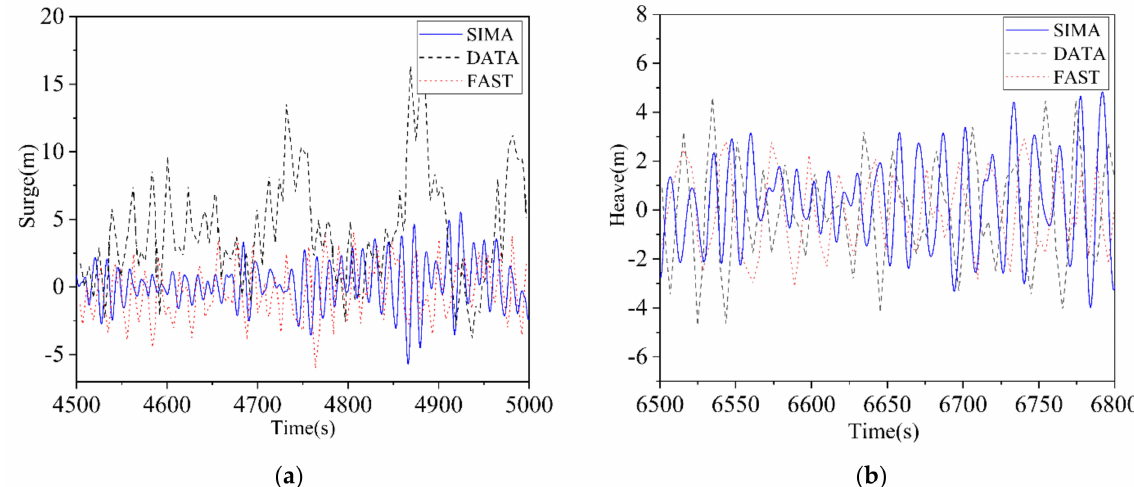
Figure 2. Comparison of SIMA simulation results under the action of irregular wave alone. ( a ) Surge motion response comparison. ( b ) Heave motion response comparison.